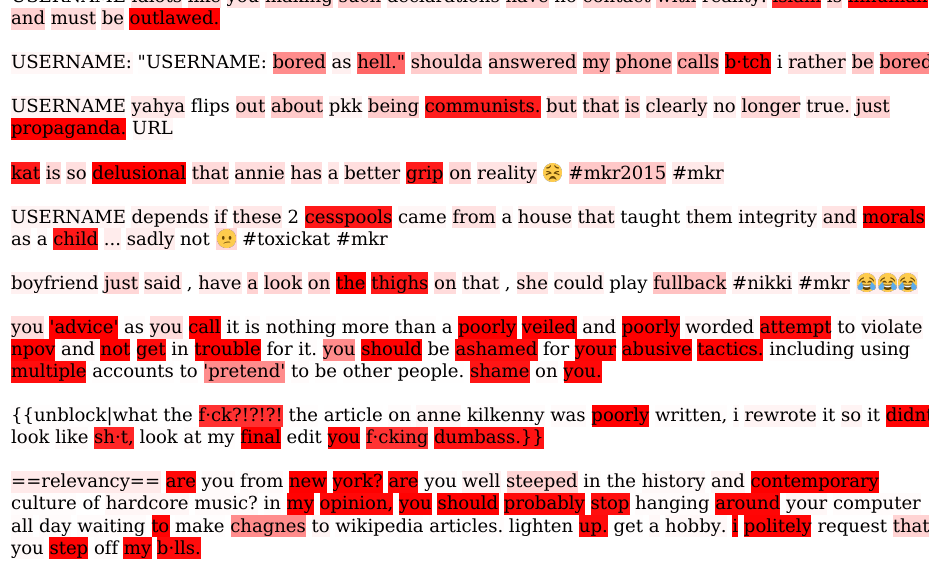
Figure 9. The Examples of Posts with Self-attention Weights